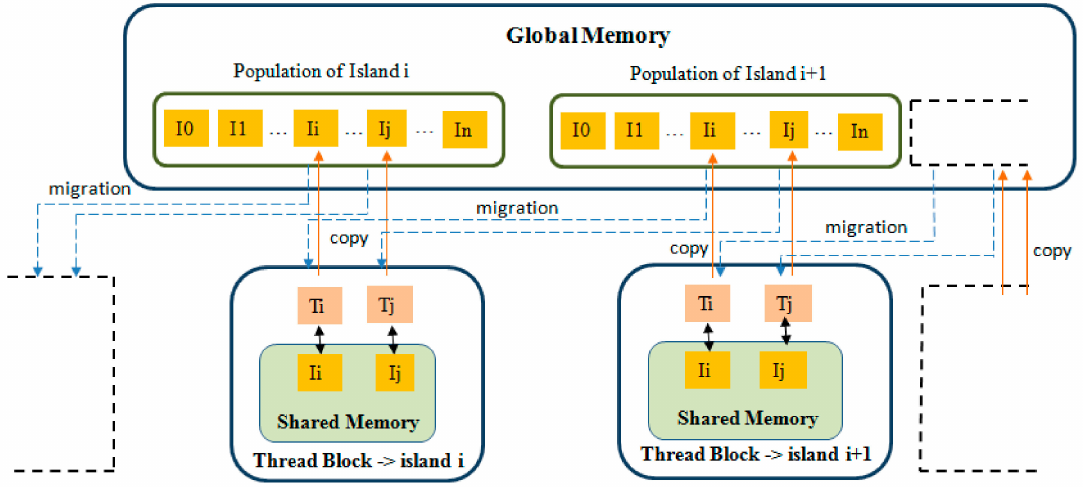
Figure 11. Migration between islands with one thread processing one chromosome (MIG_I).